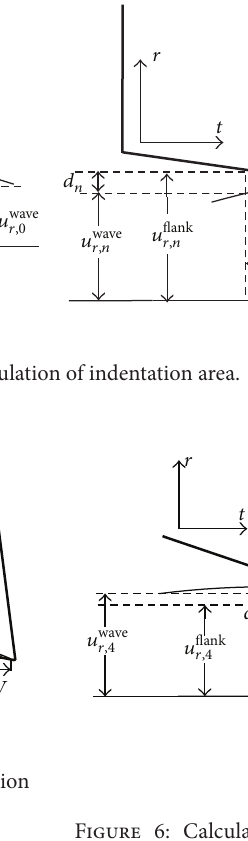
Figure 6: Calculation of indentation area (with antivibration clearance